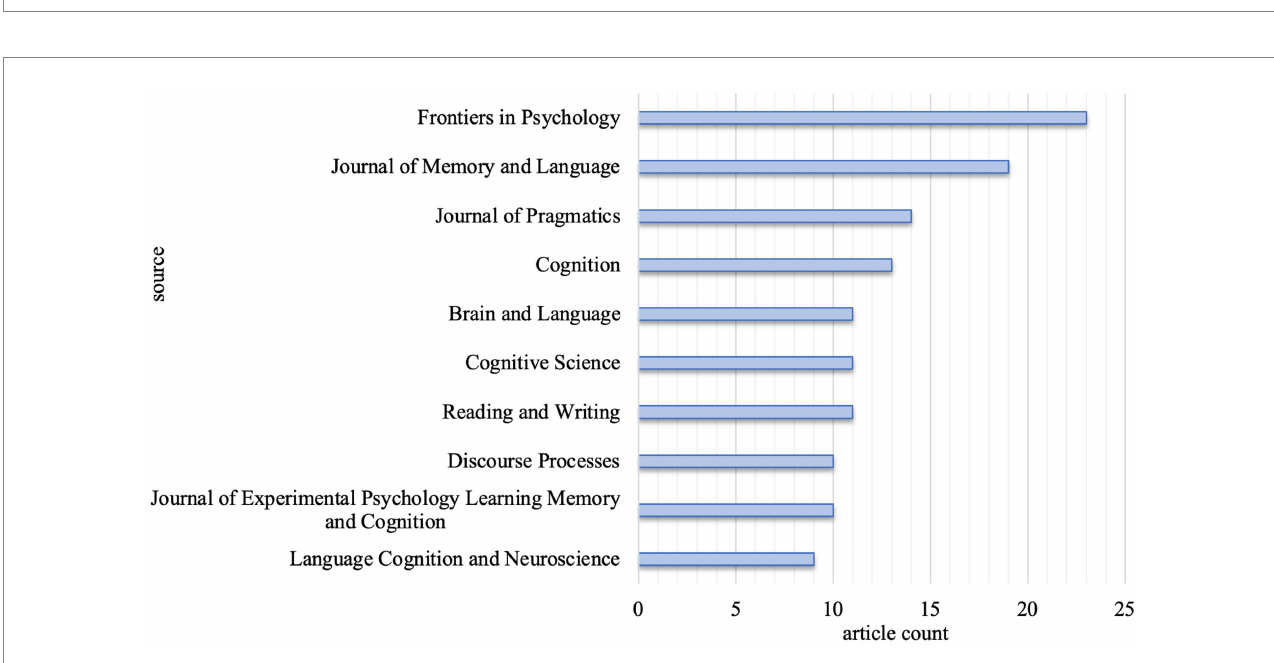
FIGURE 2 Top ten most productive